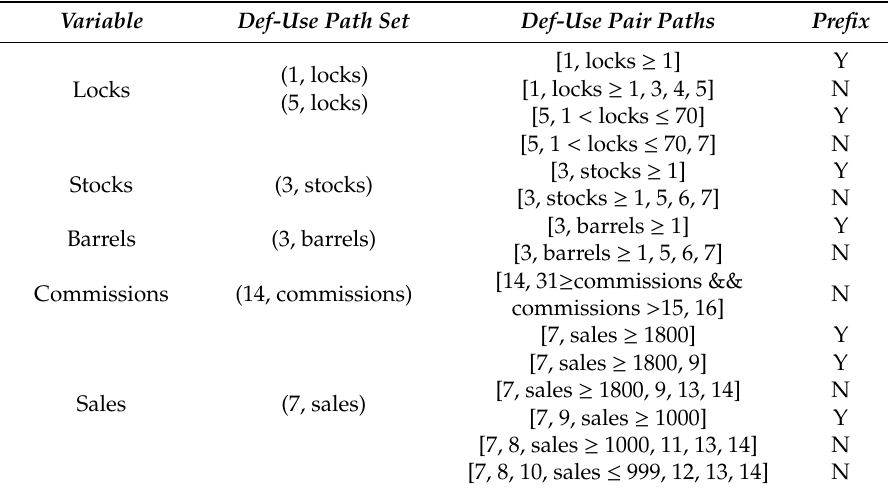
Table 1. An example of generated def-use pair